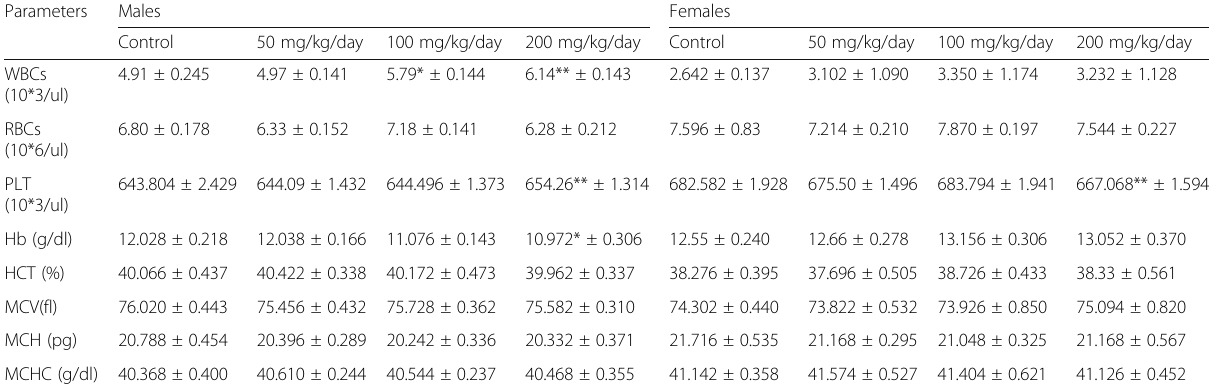
Table 3 Effect of different test doses of product on hematological parameters in male & female rats